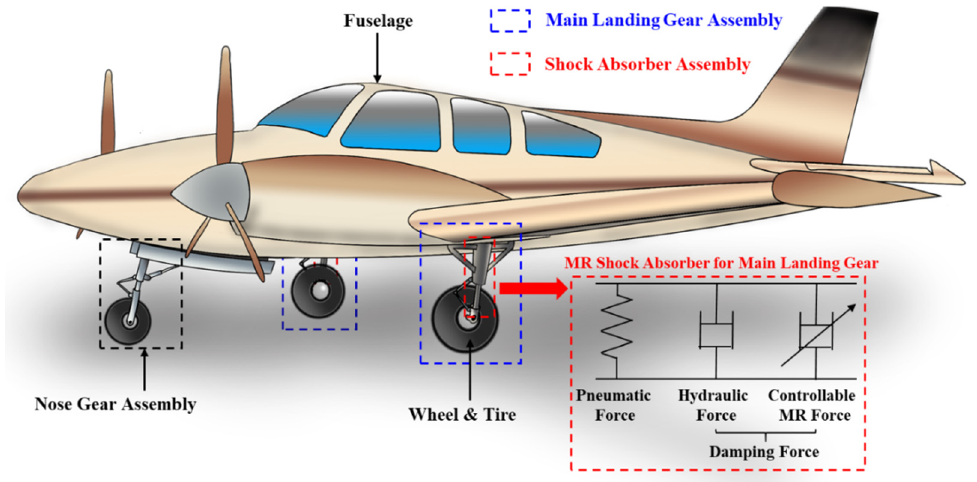
Figure 1. Configuration of aircraft landing gear and MR shock absorber.